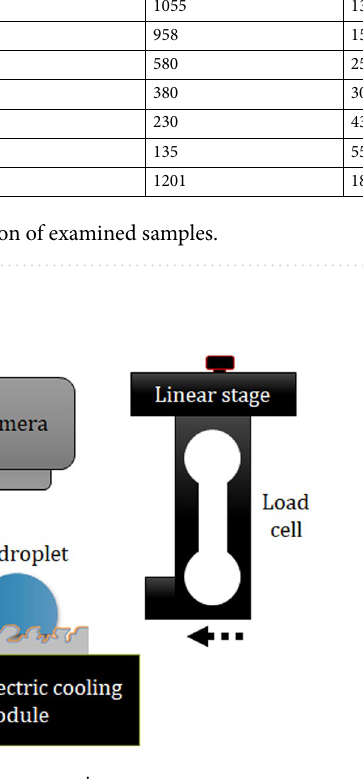
Figure 7. Experiment setup for